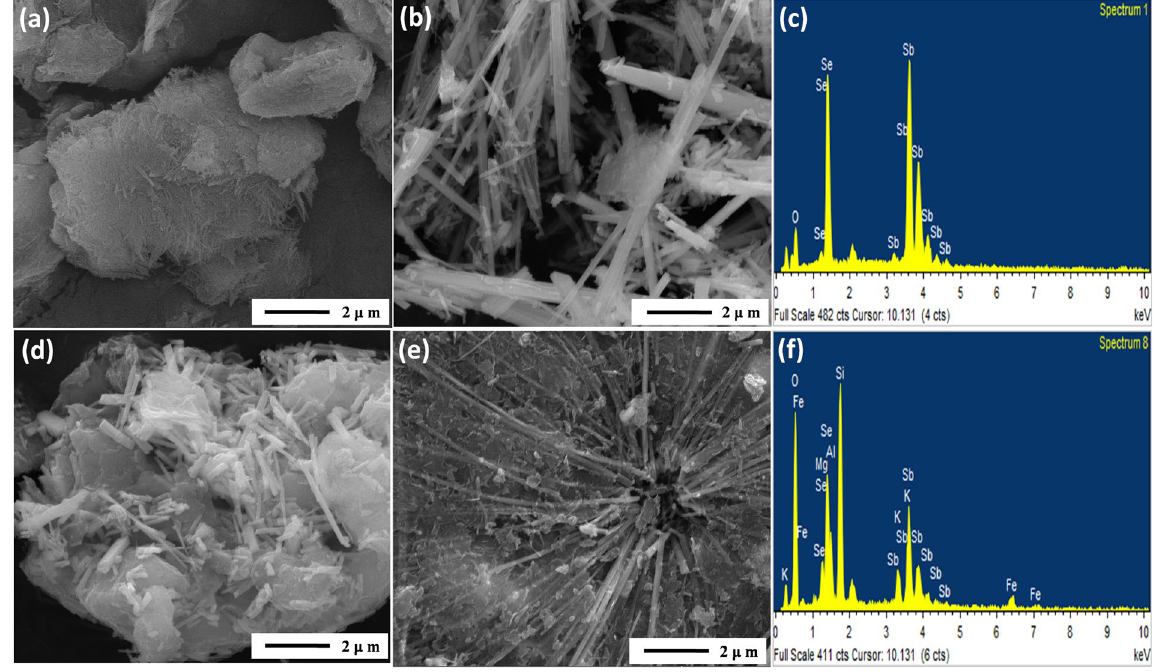
Figure 3. SEM images of ( a ) raw attapulgite, ( b ) Sb 2 Se 3 sample, ( d ) Sb 2 Se 3 -Sb 2 O 3 -attapulgite, ( e ) Sb 2 Se 3 /Sb 2 O 3 @ attapulgite composites and EDS spectra of ( c ) Sb 2 Se 3 sample and ( f ) Sb 2 Se 3 /Sb 2 O 3